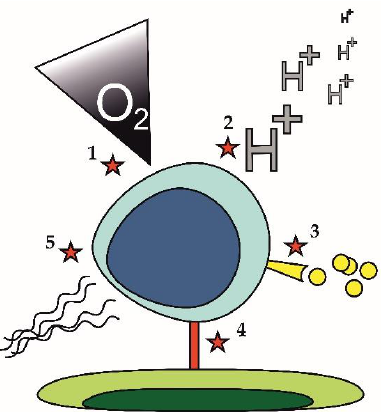
Figure 3. Cell-extrinsic mechanisms of drug resistance. 1. Hypoxia; 2. Acidosis; 3. Pro-survival growth factors and / or cytokines; 4. Cell-cell contact; 5. Alteration in the composition of extra-cellular